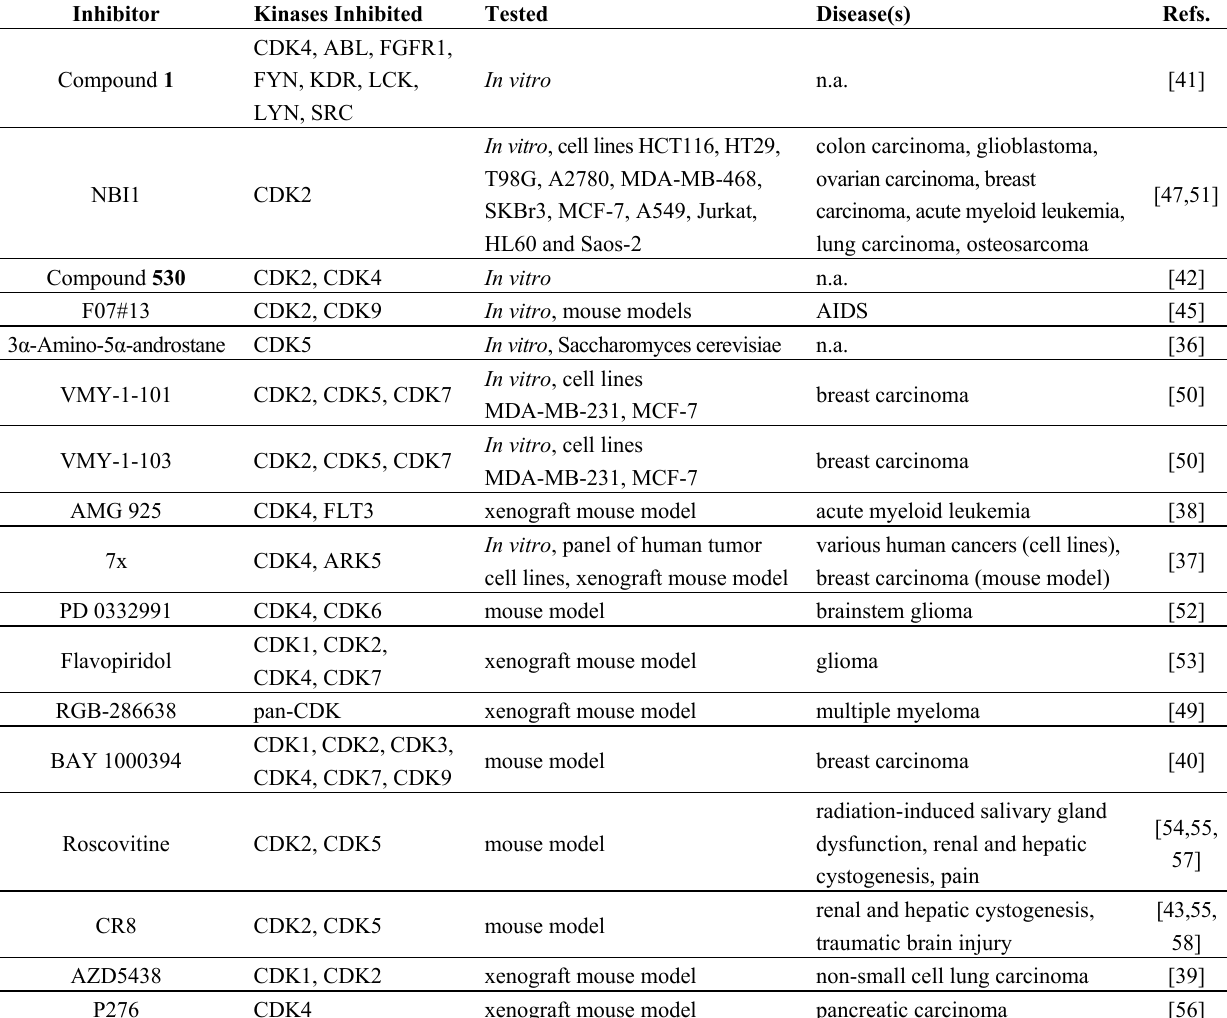
Table 2. List of CDK inhibitors described in preclinical study section.